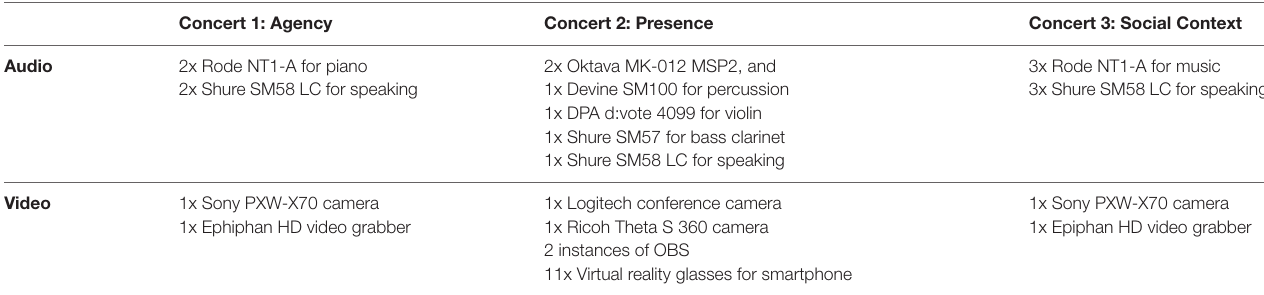
TABLE 2 | Technical setups per